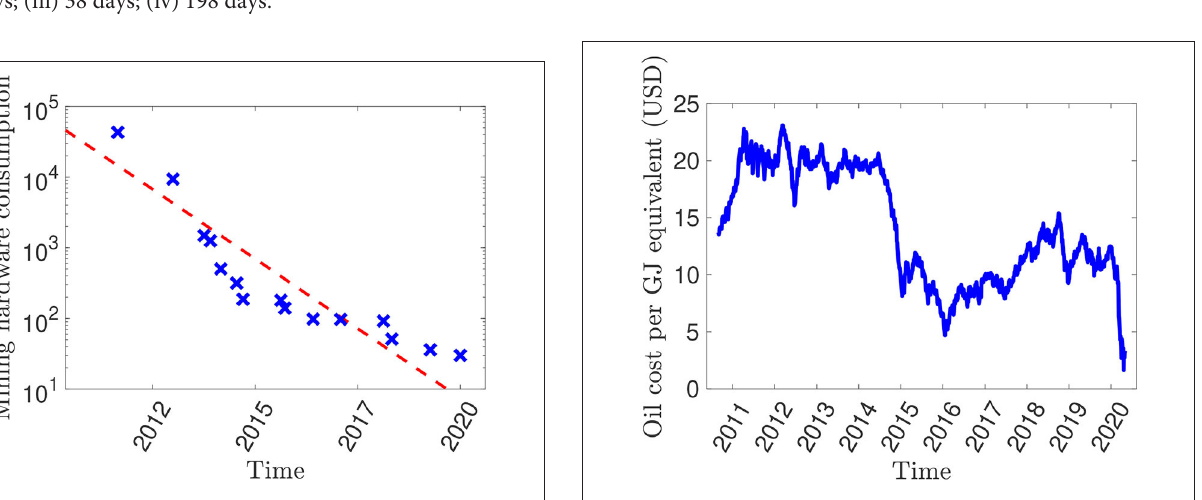
FIGURE 3 | Energy cost per gigajoule, measured in USD and converted from Brent Crude spot prices.